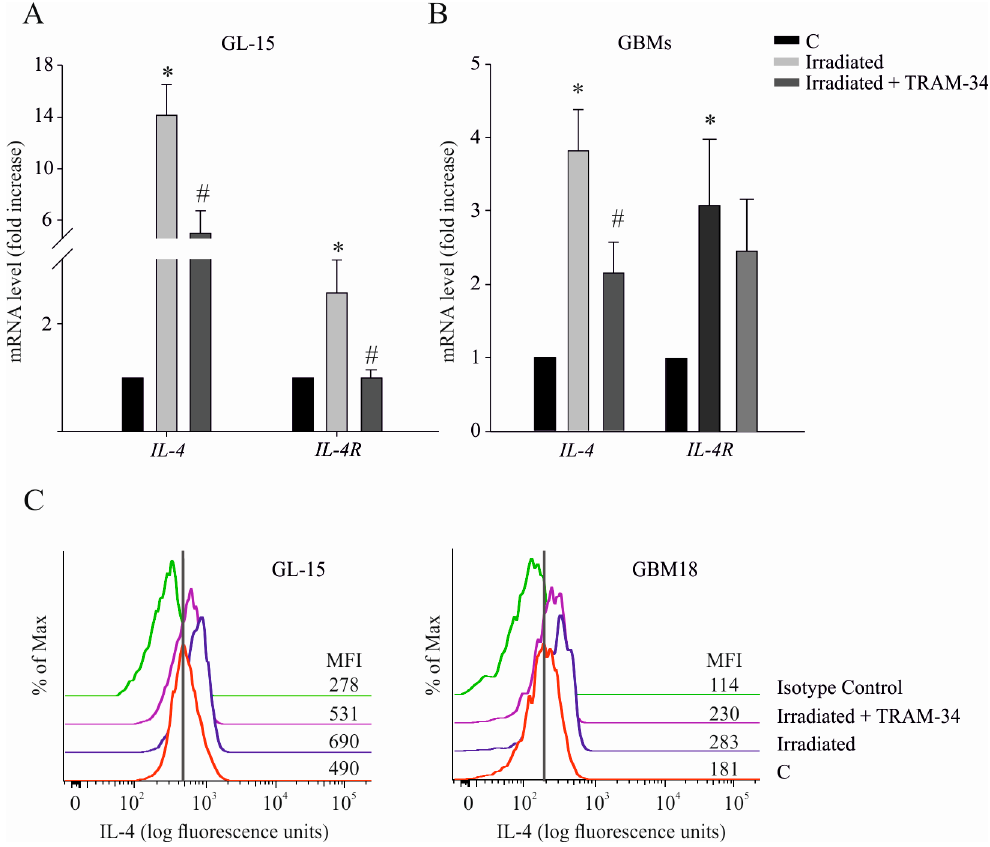
Figure 4. ( A ) Expression analysis by qRT-PCR of IL-4 and IL-4R in irradiated or untreated (C) GL-15 cells after TRAM-34 treatment (5 µM, 48 h). * p < 0.05 vs. control GL-15. # p < 0.05 vs. irradiated GL-15 n = 3 (in duplicate). ( B ) Expression analysis, by qRT-PCR, of IL-4 and IL-4R in GBMs (GBM18, GBM19, GBM45, and GBM137) * p < 0.05 vs. C; # p < 0.05 vs. irradiated GBM n = 4 (in duplicate). ( C ) IL-4 production by GL-15 and GBM18 cells, evaluated by intracellular immunostaining and flow cytometry analysis. Histograms are representative of two independent experiments. Isotype staining was performed on both control and irradiated cells. Gray line marks control histogram peak. The values shown represent the median fluorescence intensity (MFI) of each histogram/sample.